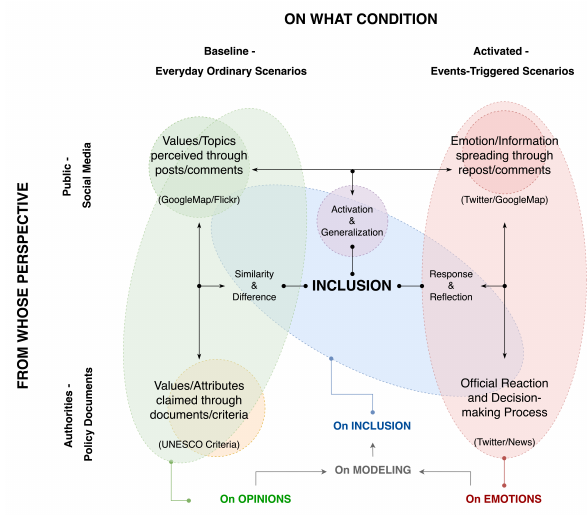
Figure 4. The proposed research framework